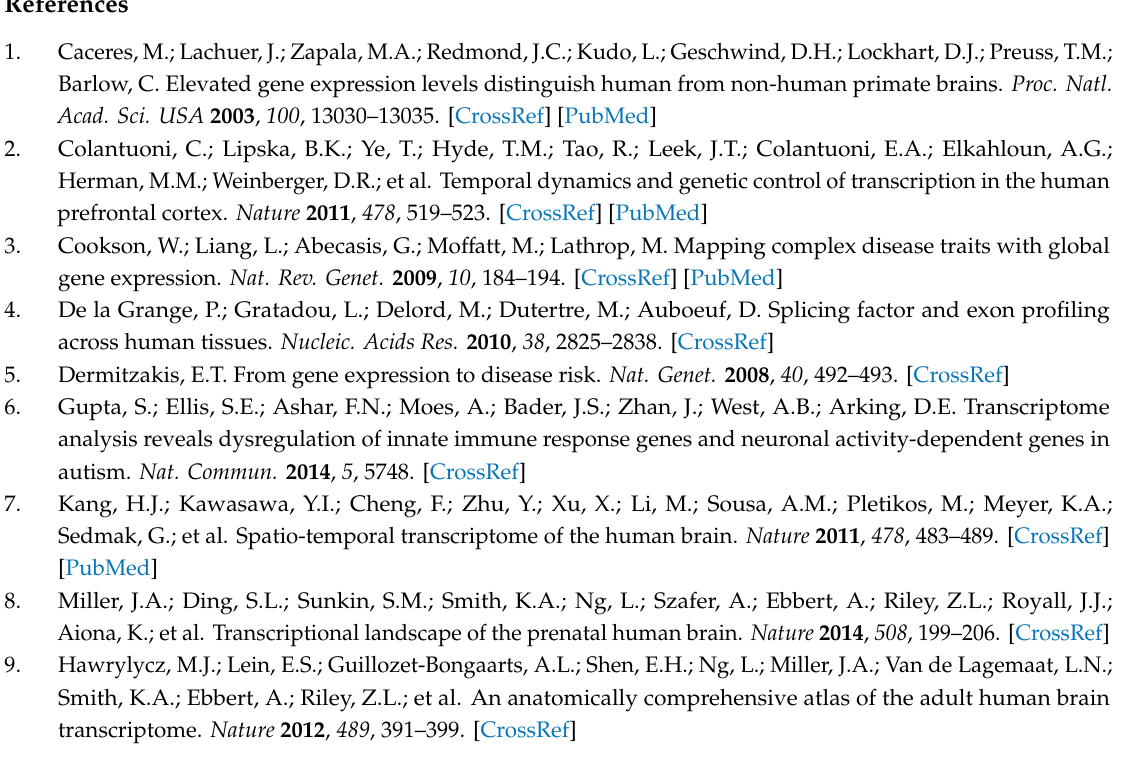
Table S1: The list of co-expressed gene modules in the WGCNA. Table S2: Co-expression modules of the early development. Table S3: Protein and gene expression of ionotropic glutamate receptor signaling (GO:0035235) and generation of neurons (GO:0048699)